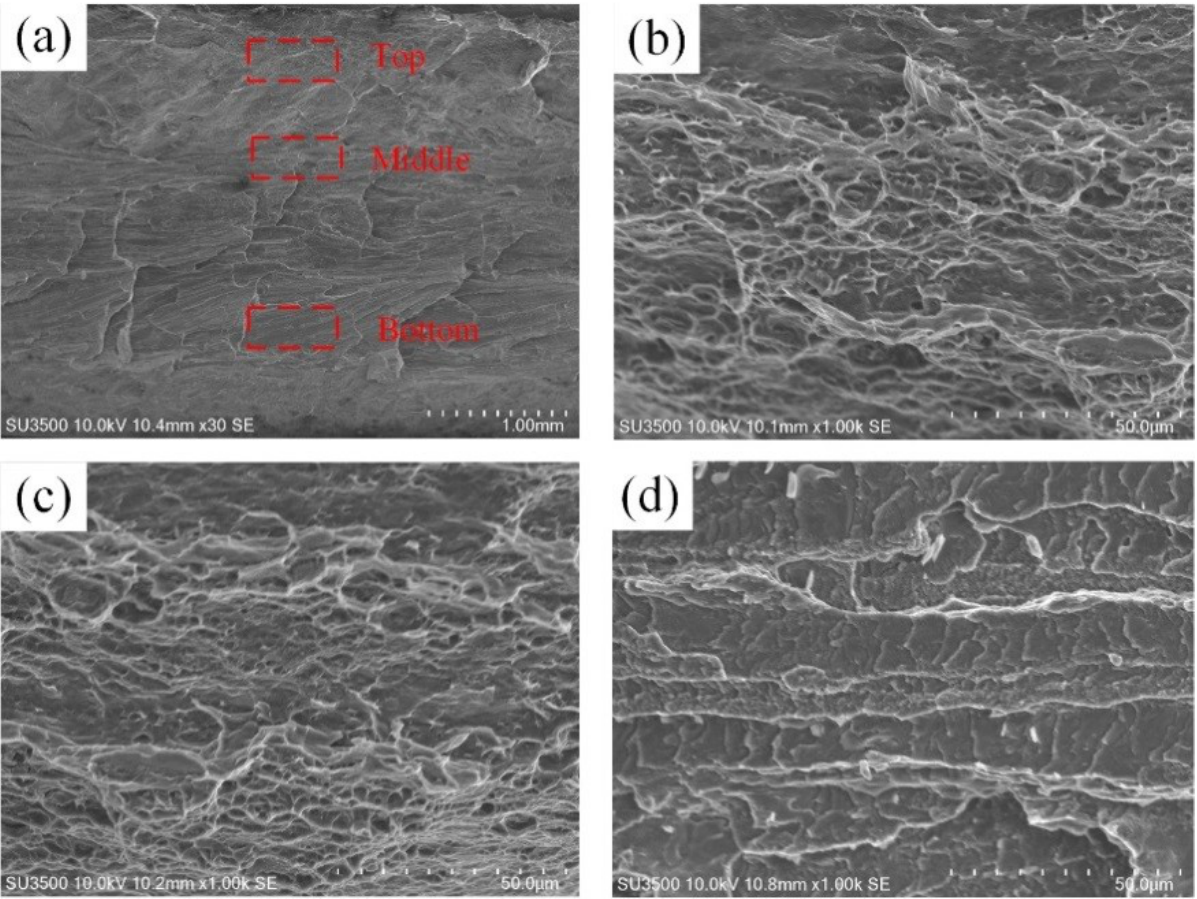
Figure 10: Fracture surface morphologies at the welding speed of 60 mm/min: (a) macroscopic of fracture surface; micro fracture surfaces at different locations in Figure 10a: (b) position b, (c) position c and (d) position d